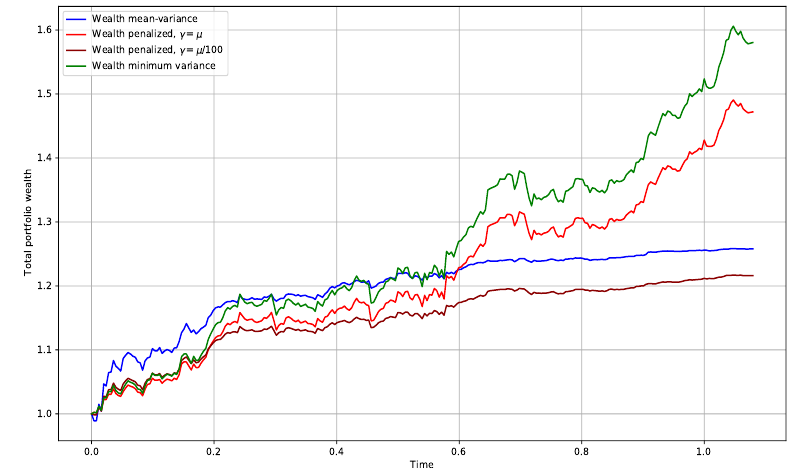
Figure 6. Sharpe ratios: Mean-variance: 0.183; Minimum variance: 0.255; Penalized γ = µ : 0.256; Penalized γ = µ /100: